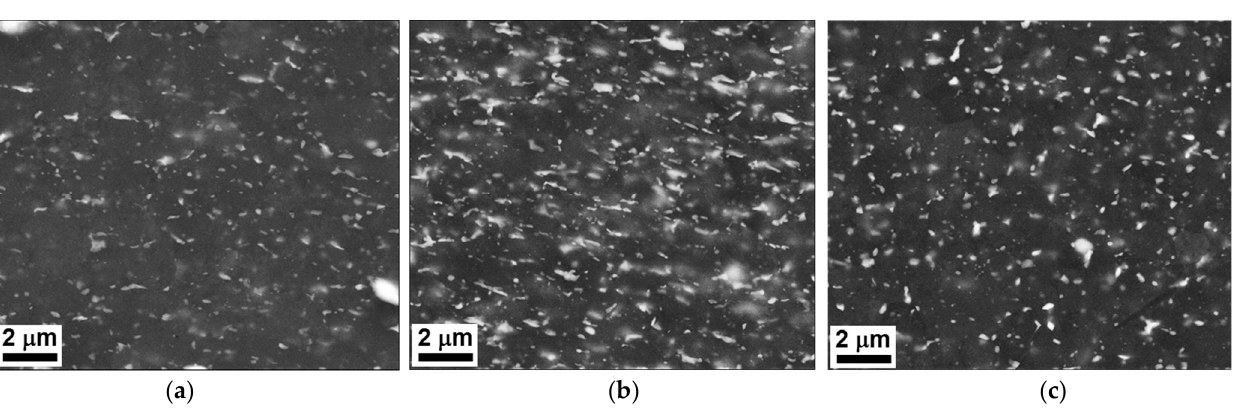
Figure 4. Typical backscatter-electron-scanning electron microscopy (BSE-SEM) images taken from different locations of low-heat-input weld: ( a ) upper surface, ( b ) weld nugget, and ( c ) weld root. Note: Secondary precipitates appear bright.